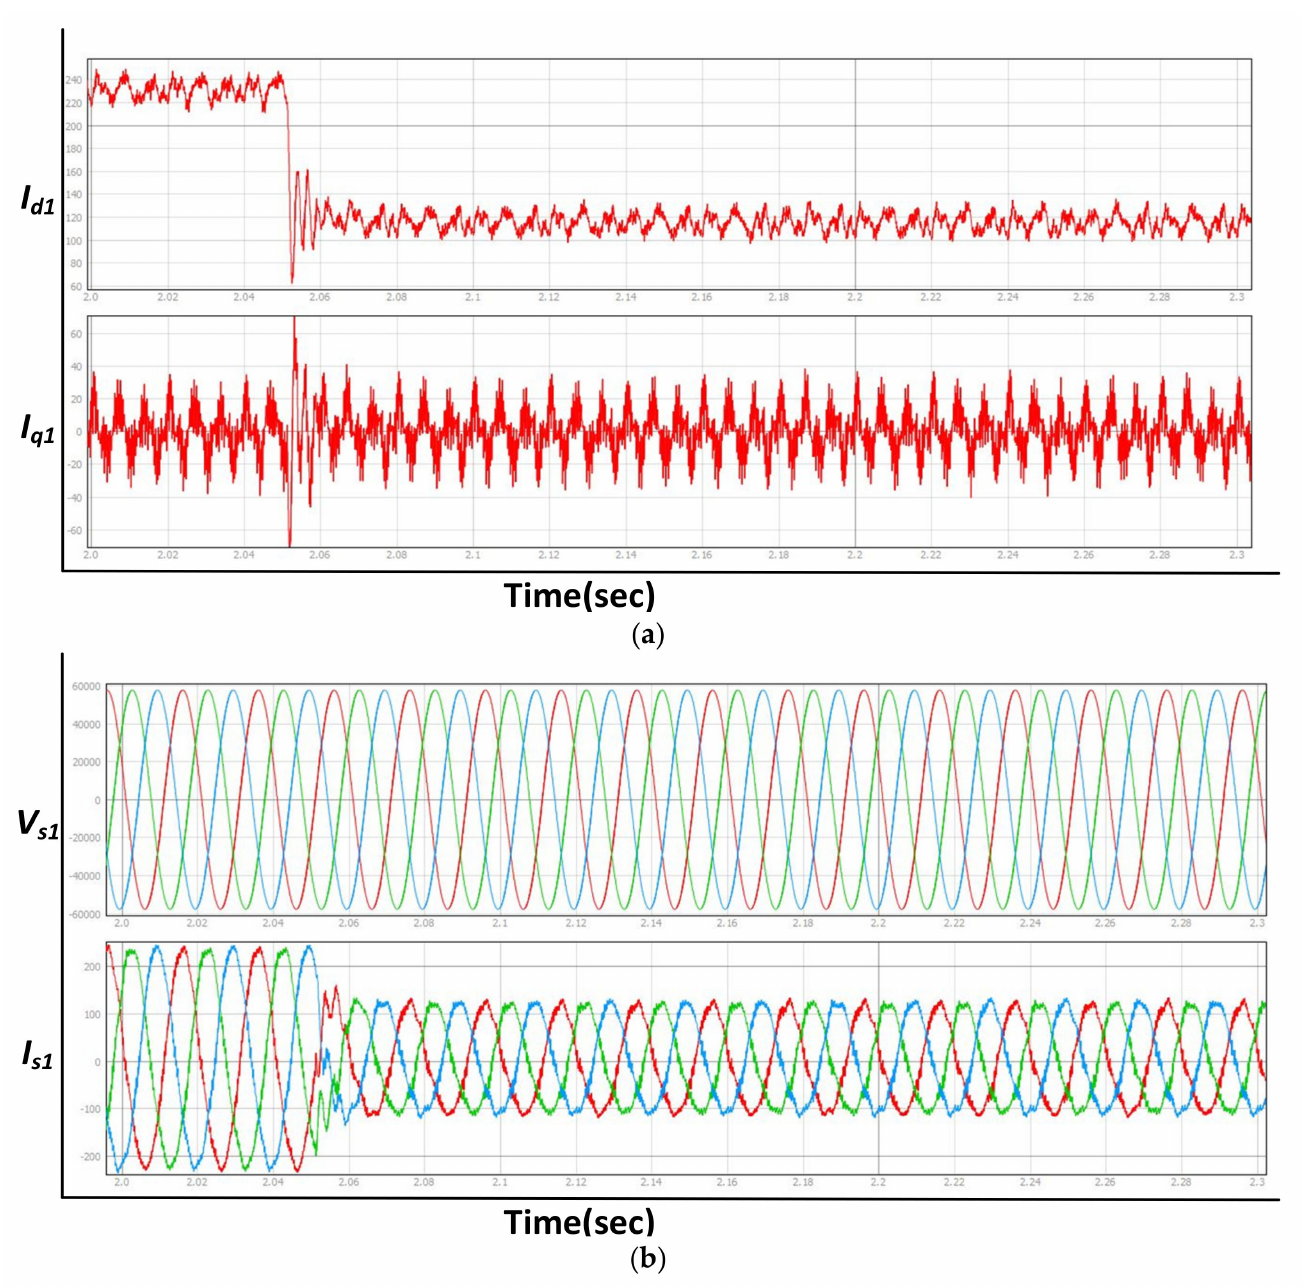
Figure 19. ( a ): Experimental results for the off-nominal case for I d 1 , I q1 of Converter Station 1 for a 50% step change in active power; ( b ): experimental results for the off-nominal case for V s1 (three phasevotlages) and I s1 (three line currents) of Converter Station 1 for a 50% step change in active